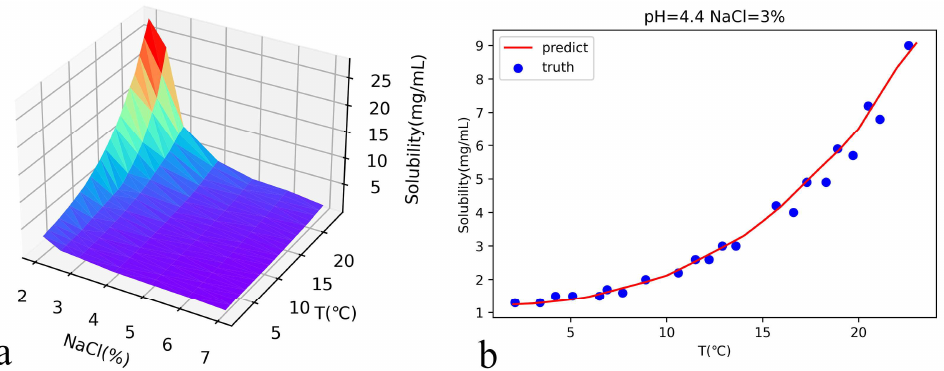
Figure 4. ( a ) pH = 4.4, the solubility of lysozyme is predicted by the neural network. ( b ) shows the comparison between the predicted results and the experimental values in Ref.[25] when the concentration of sodium chloride is 3%. The MAE between the predicted and experimental values is 0.2.